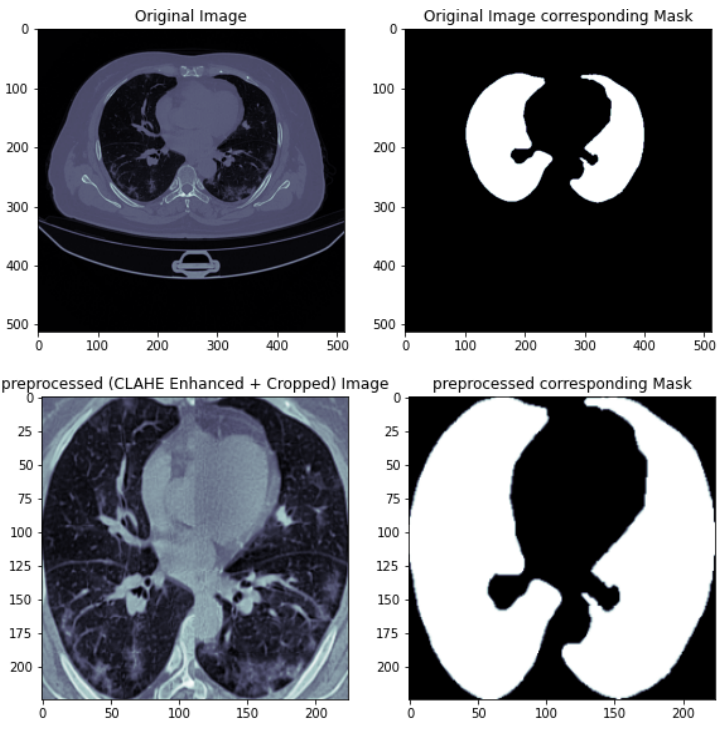
Figure 4. A chest CT scan and its corresponding lung mask before and after cropping.